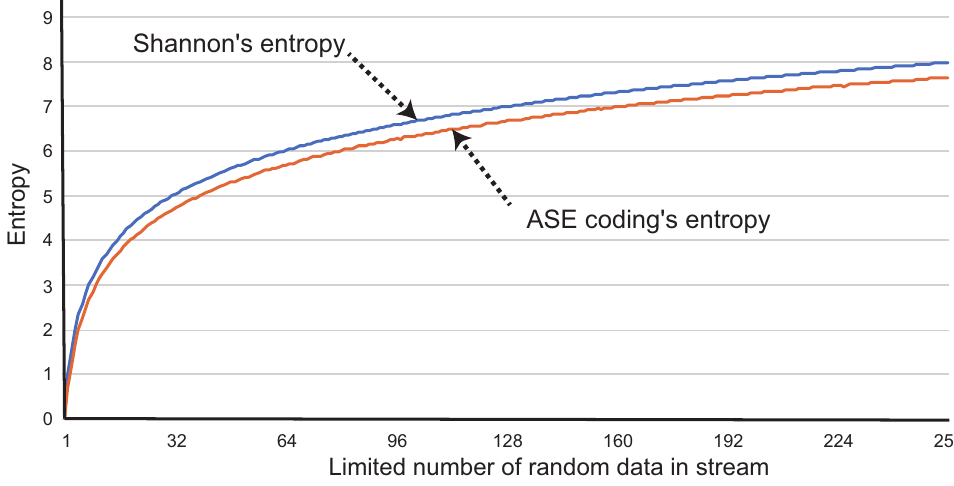
Figure 5. Entropy comparison between Shannon’s and ASE